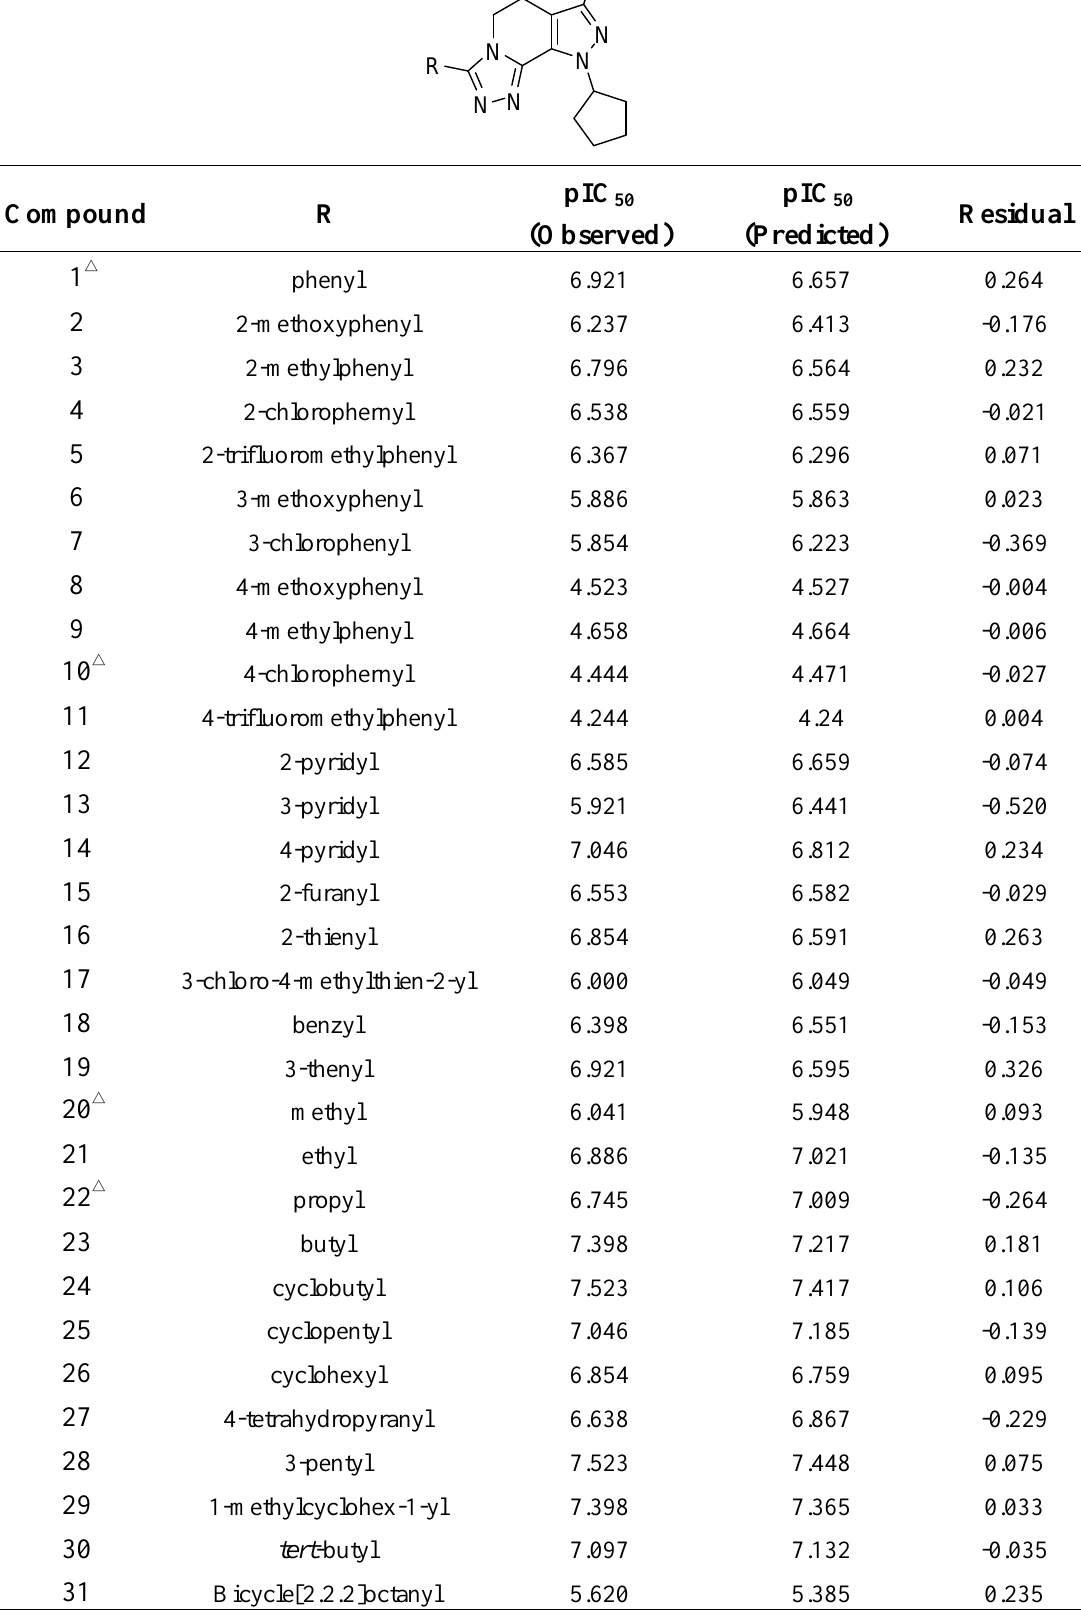
Table 1. Structures and biological activities of molecules used in the present study.